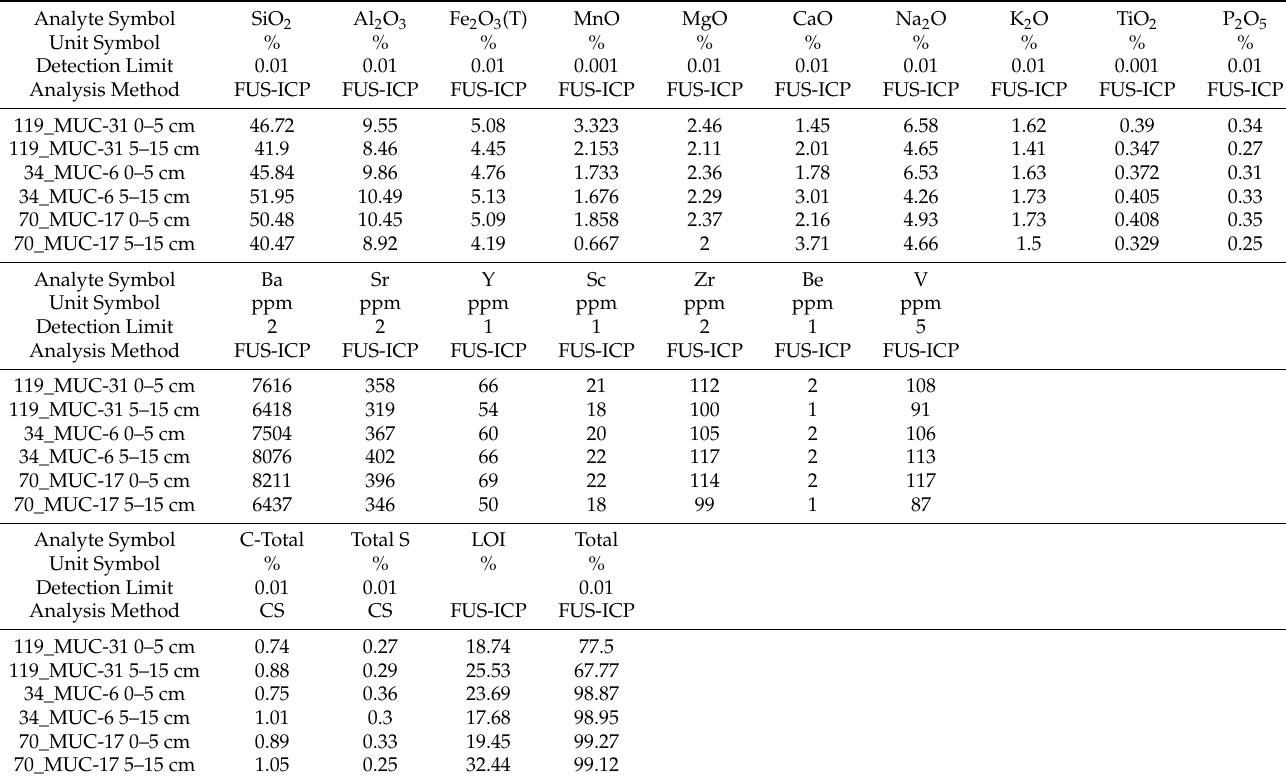
Table A2. Quantitative chemical composition of the samples in wt%.